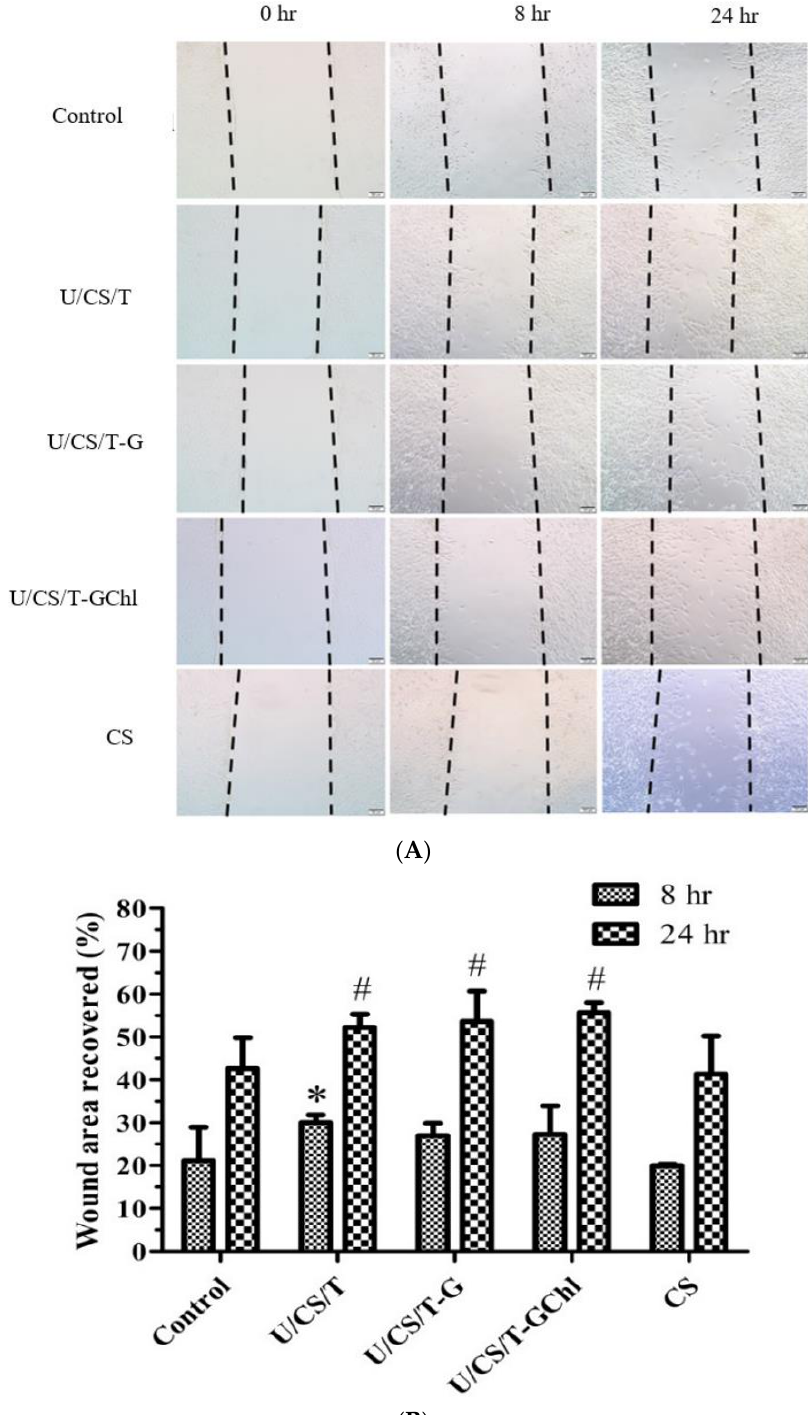
Figure 5. ( A ) Optical micrographs of NIH 3T3 cell migration affected by the ulvan/chitosan complex films. Scale bar = 500 μm; ( B ) Analysis of the migration ability as expressed by wound closure (%). Data represent mean ± SD from 3 separate experiments. Control is medium. * p < 0.05 compared with the control group at 8 h. # p < 0.05 compared with the control group at 24 h.